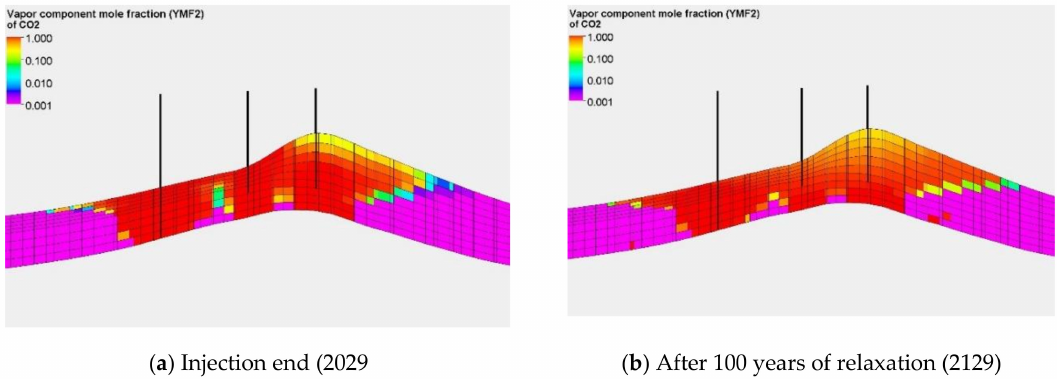
Figure 46. Distribution of CO 2 concentration in the gas phase along the vertical cross section (A–A’).